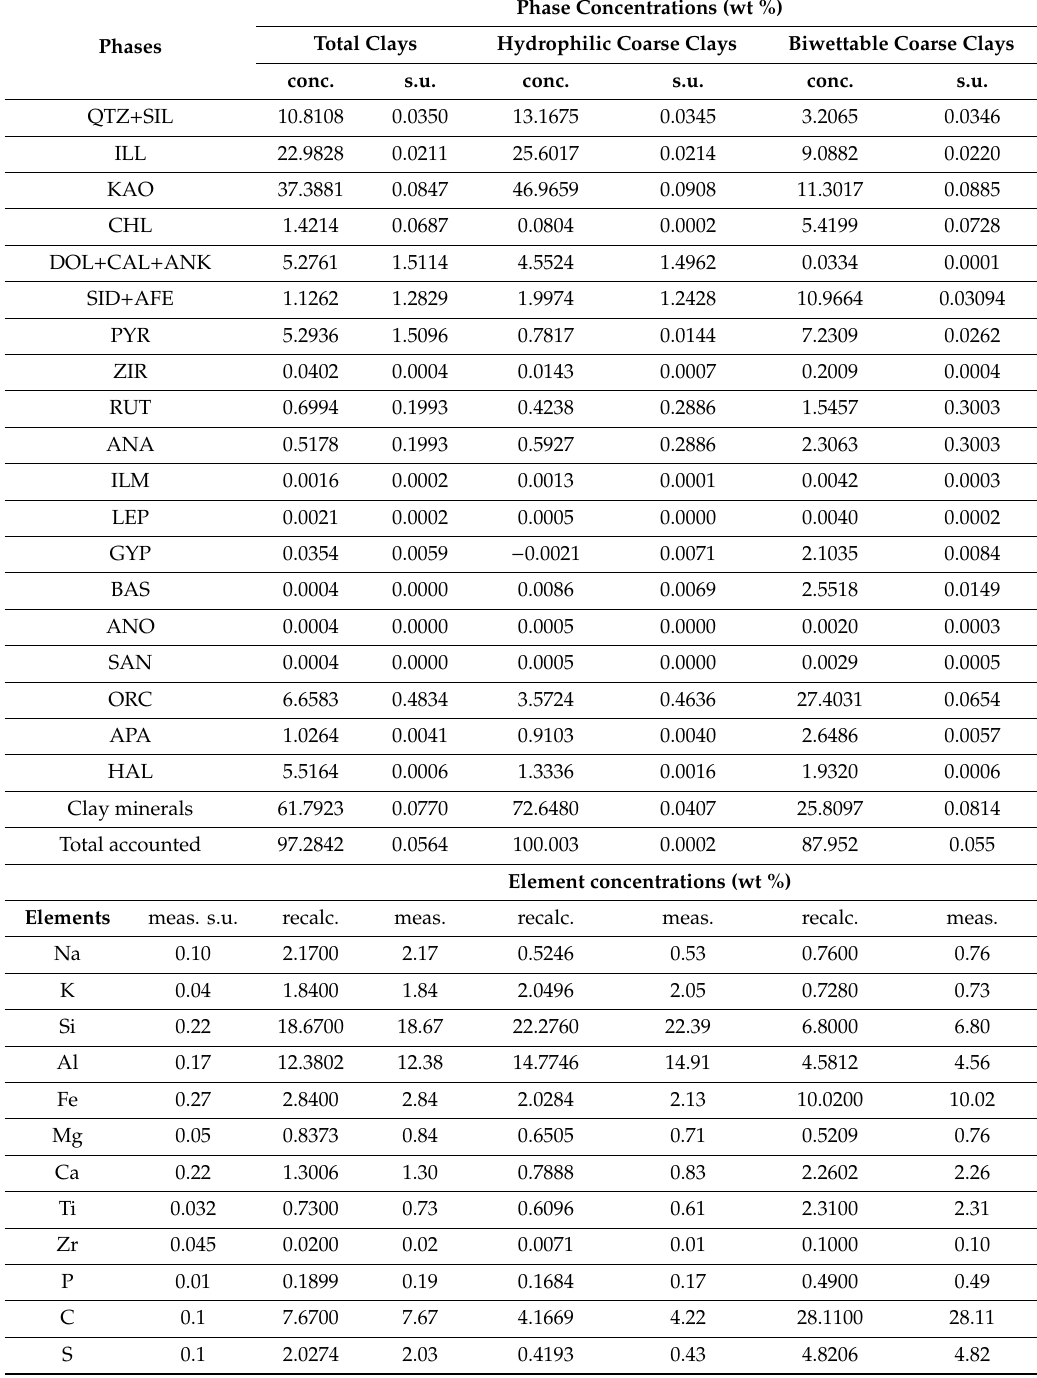
Table 2. Elemental and mineralogical compositions determined for total clays ( < 2 µ m solids) and hydrophilic and biwettable coarse clays (0.2–2 µ m solids) separated from typical commercial oil sands bitumen froth. (See notes at bottom of table for explanations of the various acronyms used and data